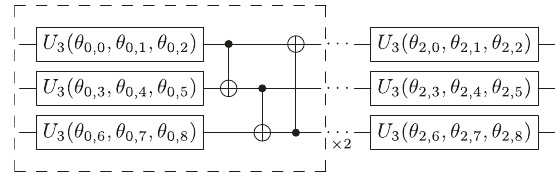
Fig. 9 Three qubit parameterized ansatz U ( α ) used for VED. The quantum circuit within the dotted block is repeated